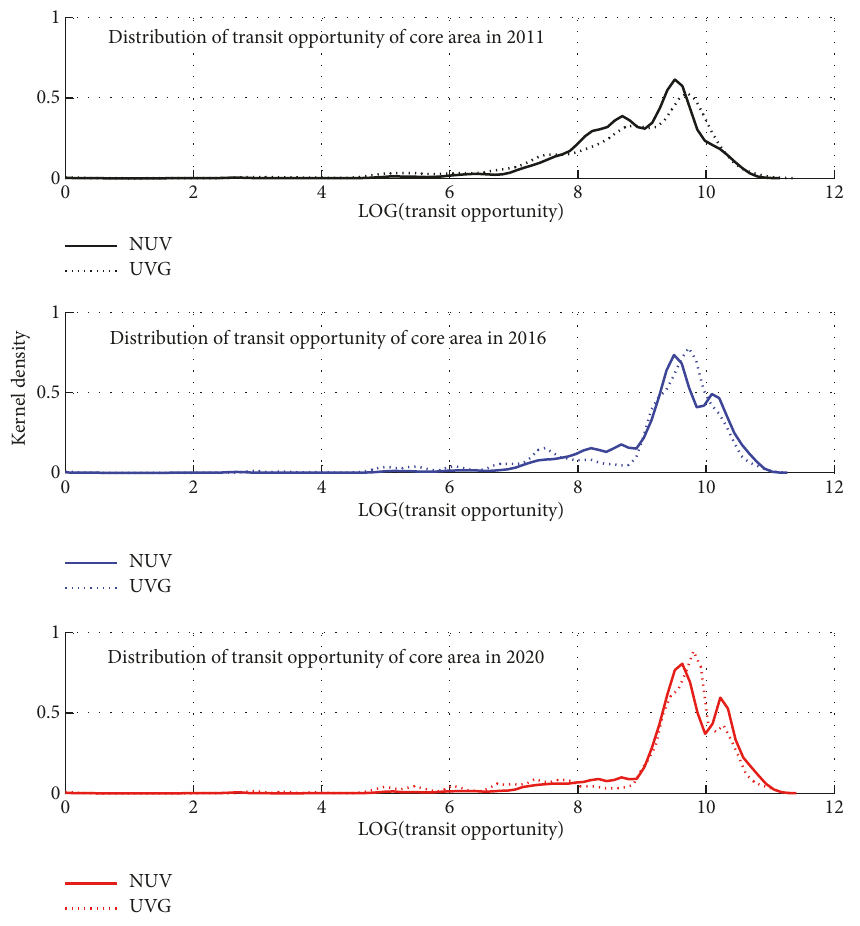
Figure 6: Comparisons of the probability distribution of the two groups in core